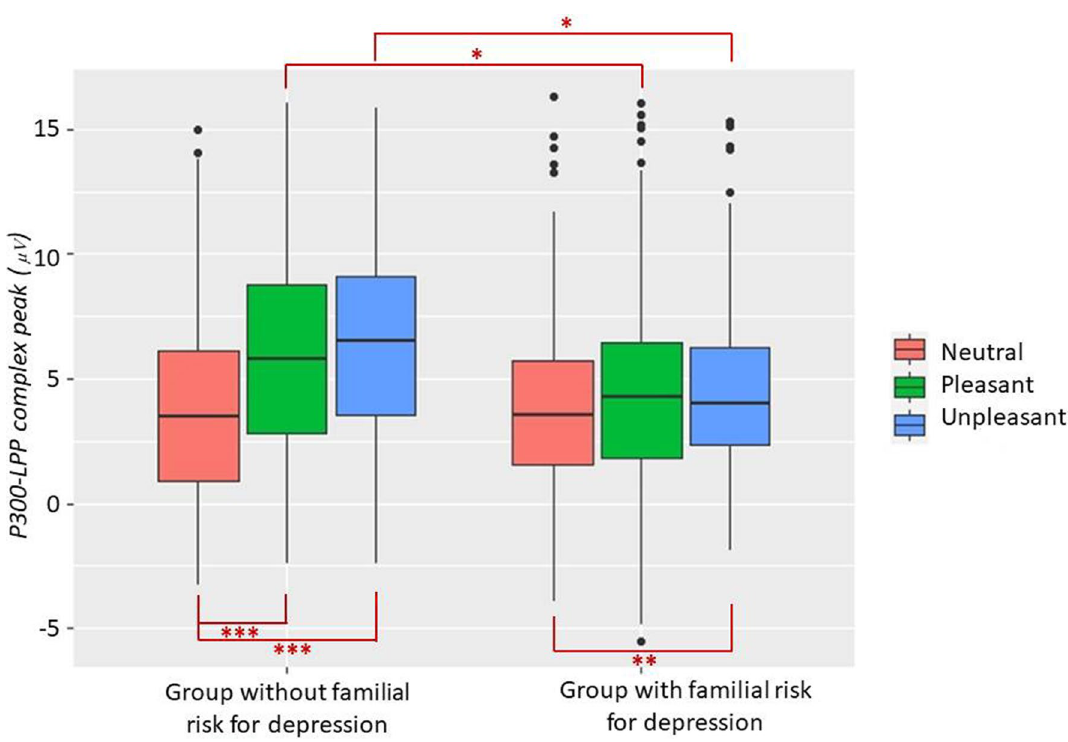
Figure 3. Boxplot of P300-LPP complex peaks (averaged over channels) for each emotional category in the group with and without familial risk for depression. On each box, the central mark is the median and the edges of the box are the 25th and 75th percentiles. * p < .05; ** p < .01; *** p <